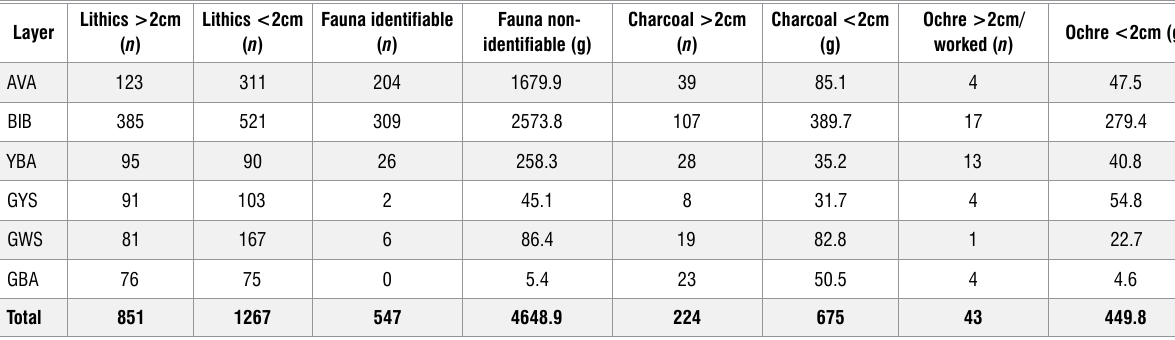
Archaeological finds, per layer, from the 2022 excavation campaign at Holley Shelter Lithics >2cm Layer ( n